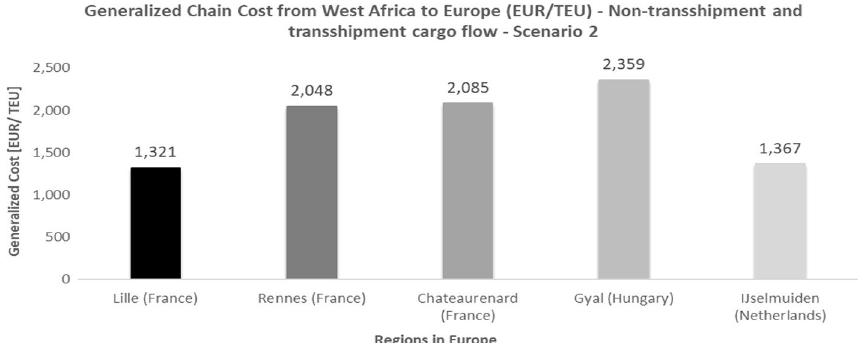
Fig. 8 Supply chain cost—scenario